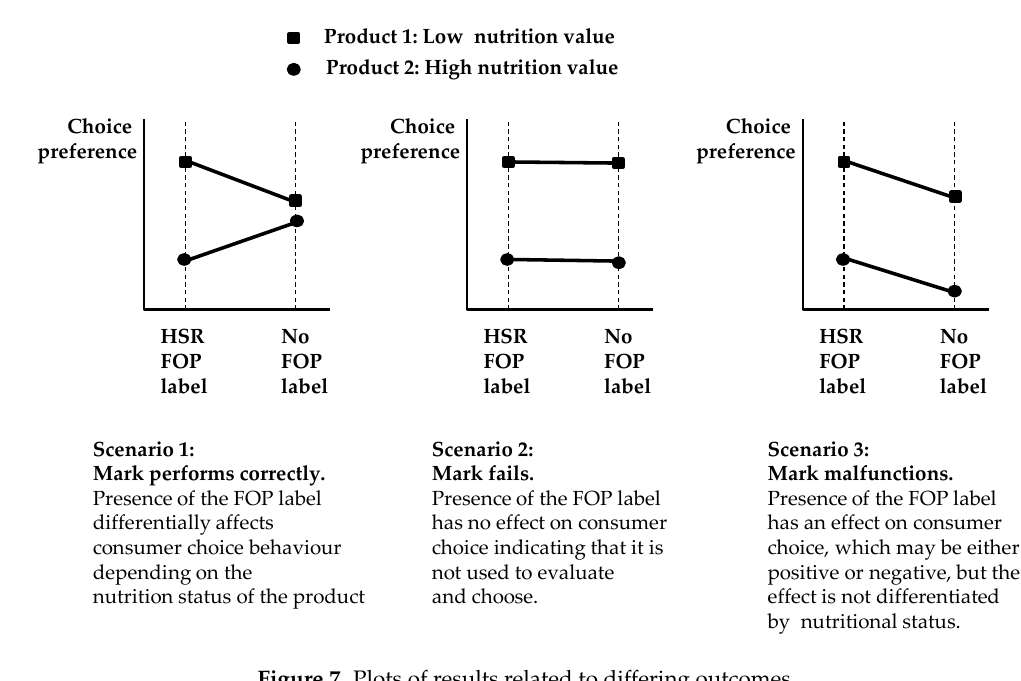
Figure 7. Plots of results related to differing outcomes.